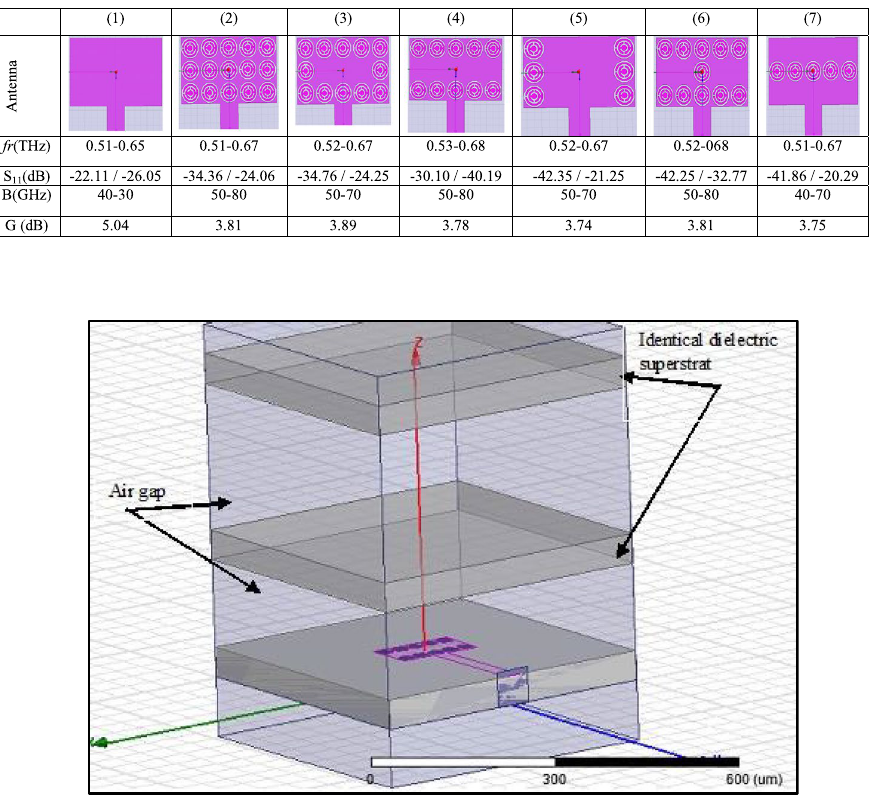
Fig. 15 Microstrip patch antenna with dielectric superstrate